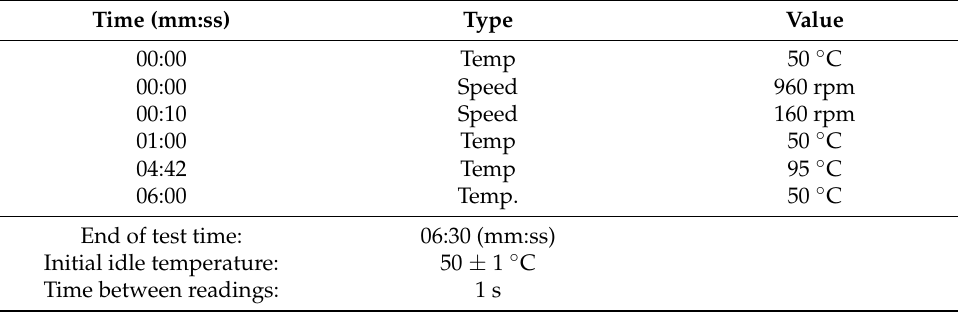
Table 1. Temperature-time regime and pre-setting of the analysis